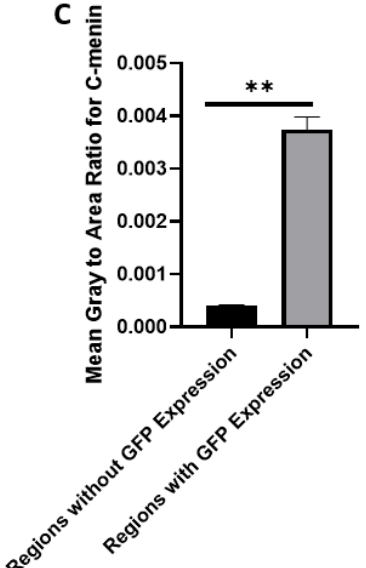
Figure 10. In vitro expression of MEN1 rescue virus, pAAV-hSyn-HI-eGFP-MEN1, in the hippocam- pal cultured neurons. ( A ) The GFP-expressing neurons after the transduction of the MEN1 rescue virus; ( i ) the GFP-expressing neurons; ( ii ) DAPI for nuclear staining; ( iii ) C-menin expression in the neurons; ( iv ) merge for showing the overlap between GFP-expressing neurons, DAPI, and C-menin; ( B ) the non-GFP expressing regions (controls); ( i ) the non-GFP-expressing neurons; ( ii ) DAPI for nuclear staining; ( iii ) C-menin expression in the neurons; ( iv ) merge for showing the overlap between GFP expression, DAPI, and C-menin; ( C ) summary data, showing the mean gray-to-area ratio for Cy5 channel for C-menin in GFP expressing and non-GFP expressing regions, indicating an increase in C-menin expression in GFP-expressing neurons. Data represent the mean ± SEM, n = 4, Statistical significance (Mann–Whitney U test), ** p < 0.05.